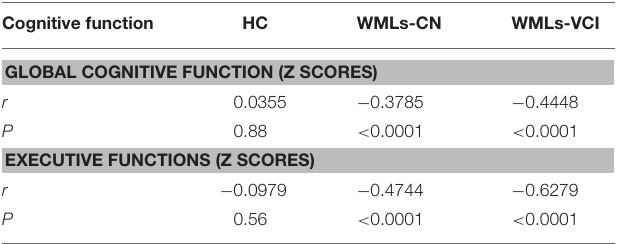
TABLE 4 | Correlation between cognitive function and the peak width of skeletonized mean diffusivity. Cognitive